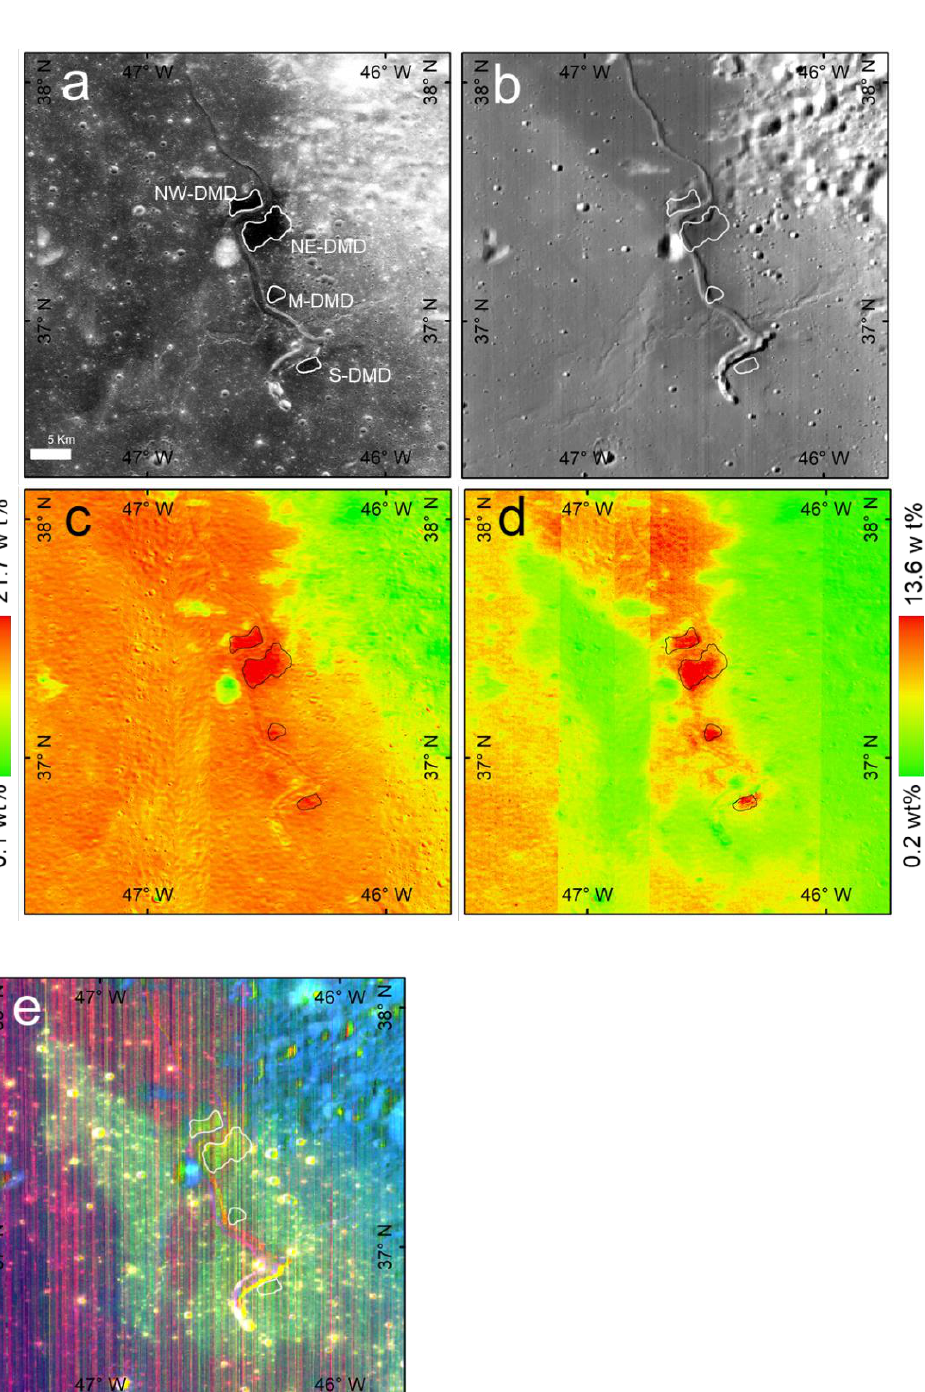
Figure 2. The geologic background of the researched area, with white circles denoting dark mantle deposits (DMDs). ( a ) CE-2 DOM data: DMDs are abnormally dark. ( b ) M 3 Reflectance at 2.49 µ m. ( c ) MI-derived FeO content distribution. ( d ) MI-derived TiO 2 content distribution map. DMDs show higher iron and titanium contents. ( e ) M 3 IBD false-color image. Red for 1 µ m IBD, green for 2 µ m IBD, and blue for reflectance at 1.58 µ m. The regions rich in mafic minerals are yellow/green to orange/red, while the highlands are blue. The DMDs display a yellow-green, which is different from the surrounding materials.